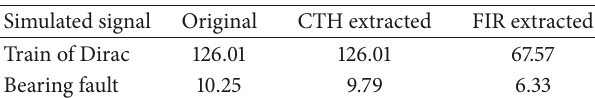
Table 1: Kurtosis